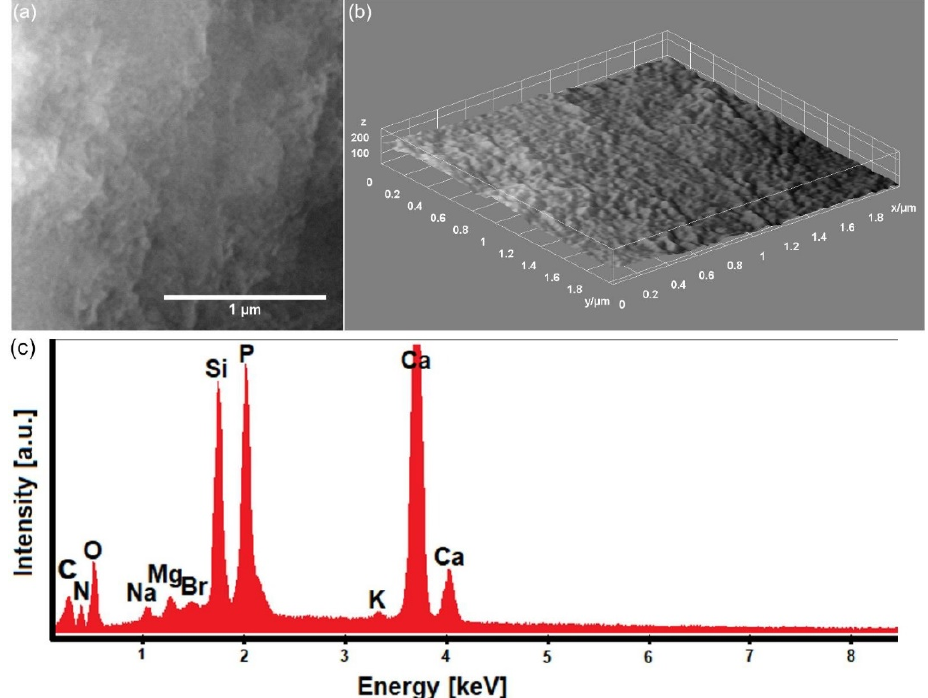
Figure 6. 2D ( a ) and 3D representation ( b ) of SEM images specific to NBrHAp composite layers. EDS spectra of N and Br co-doped HAp composite layers ( c ). spectra of N and Br co-doped HAp composite layers ( c